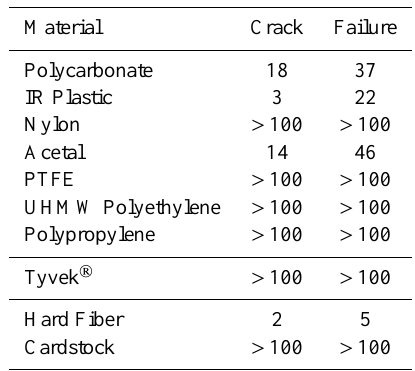
Table 5. Fatigue cycles for 0.25mm (0.01in) thick materials.